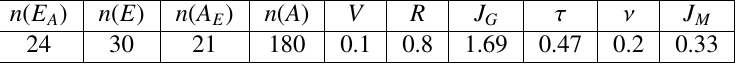
Figure 4. The diagram of errors for the parameter ξ P in predicting earthquakes with K S ≥ 13 . 5. The lower bounds of the confidence interval of the random forecast with the significance level are marked α = 0 . 01 and α = 0 . 05. Table 2. The predictive e ffi ciency of the complex ionospheric